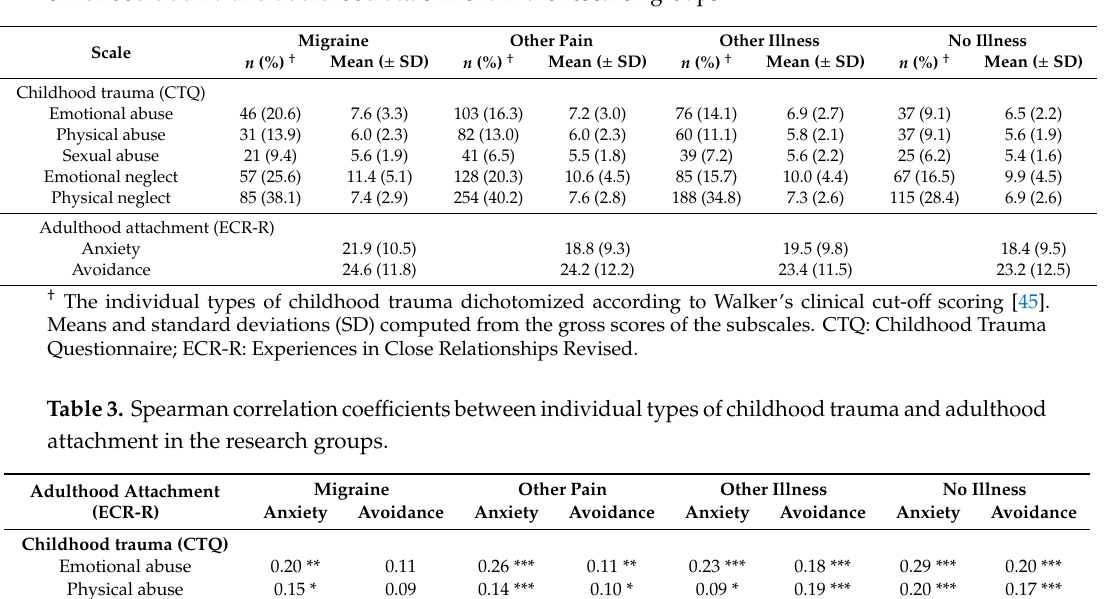
Table 2. Prevalence of individual types of childhood trauma, and descriptive characteristics of childhood trauma and adulthood attachment in the research groups.